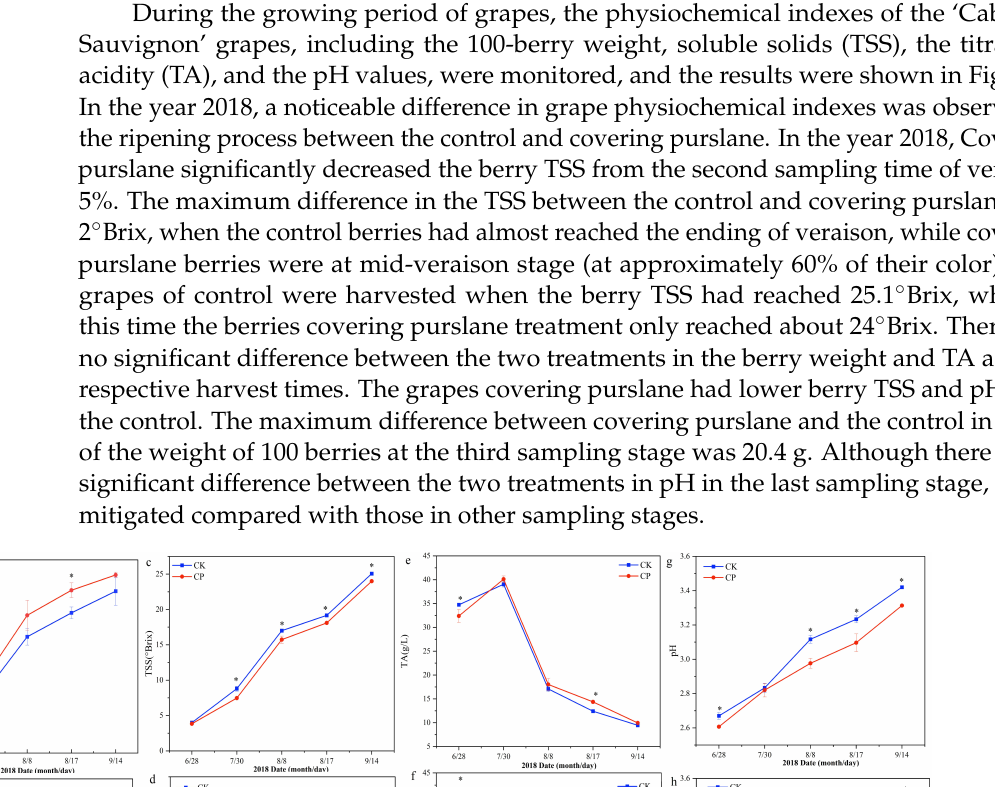
Figure 4 . Effect of covering purslane on different flavonoid concentrations of grape berries. Glu, glucoside from anthocyanins or flavonols; Ace, acetylated anthocyanins; Cou, coumarylated anthocyanins; Gal, galactosidic flavonols; Gluc, glicironide form flavonols; F3′H, 3′-hydroxylated anthocyanins or flavonols; F3′5′H, 3′5′-hydroxylated anthocyanins or flavonols; F3H, 3-hydroxylated flavonols; Free, free monomers. * indicates significant differences between the control and covering purslane ( p < 0.05, t -test), ns, not significant.